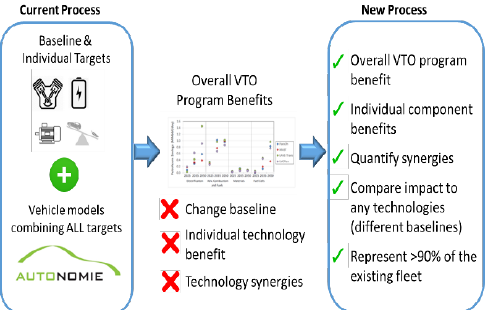
Figure 1. Innovative process to quantify VTO R&D portfolio.